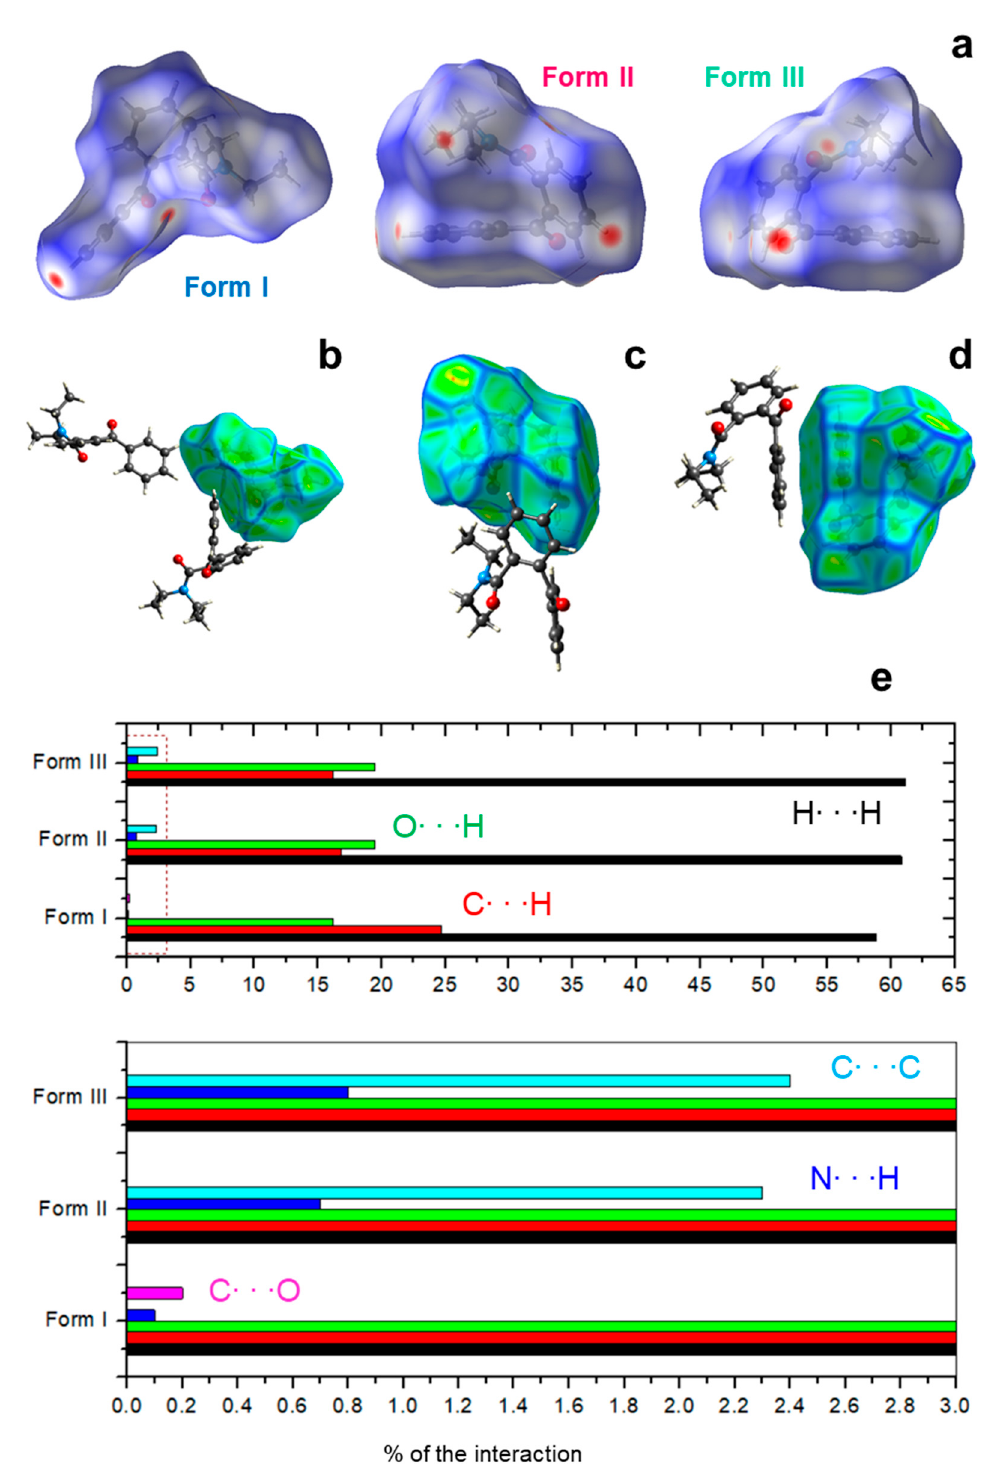
Figure 4. Hirshfeld surfaces for the three known forms of BDB ( a ), herringbone stacking present in form I ( b ) and forms II and III ( c ), cofacial π – π interaction present in forms II and III ( d ) and distribution of the intermolecular interactions for all forms of BDB with the area below 3.0% zoomed-in ( e ).